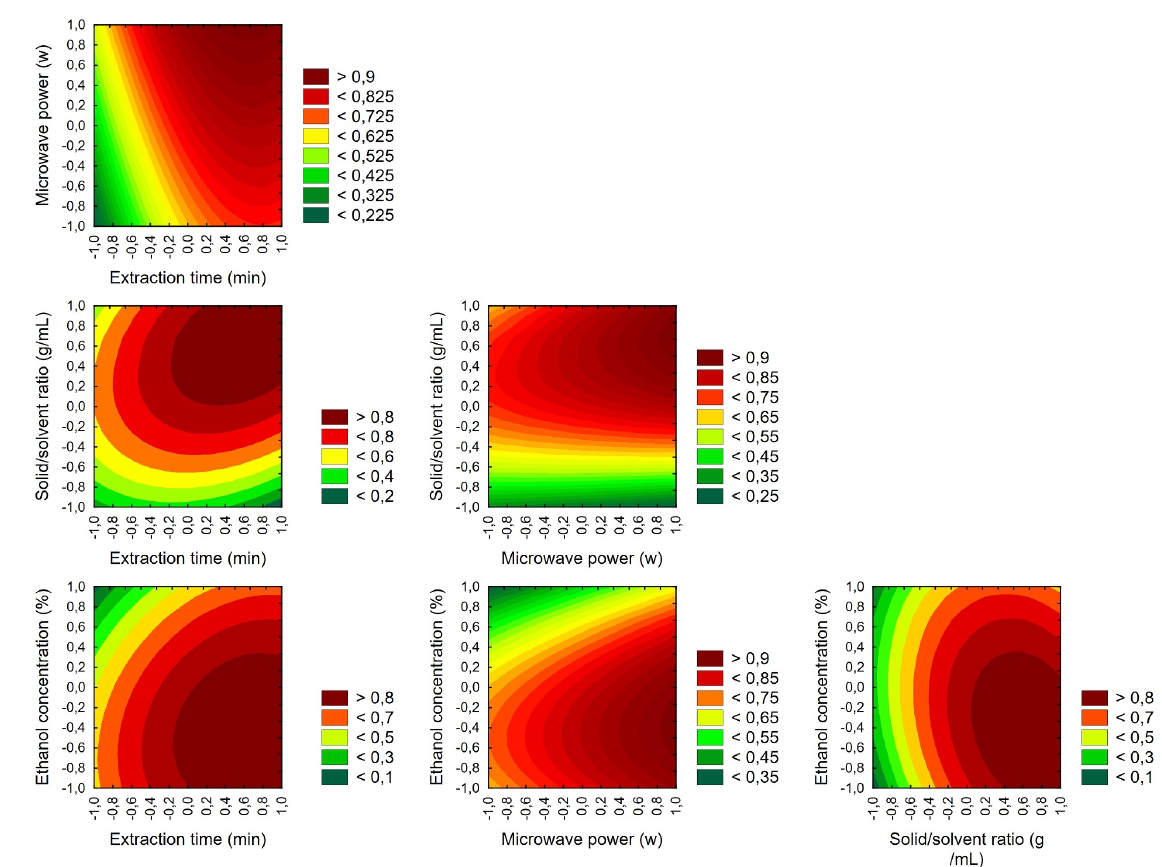
Figure 1. Contours of response surfaces obtained for polyphenol and total tannin’s extraction optimization from S. cumini leaves through microwave-assisted extraction. Contour colors are associated to the global desirability between 0 and